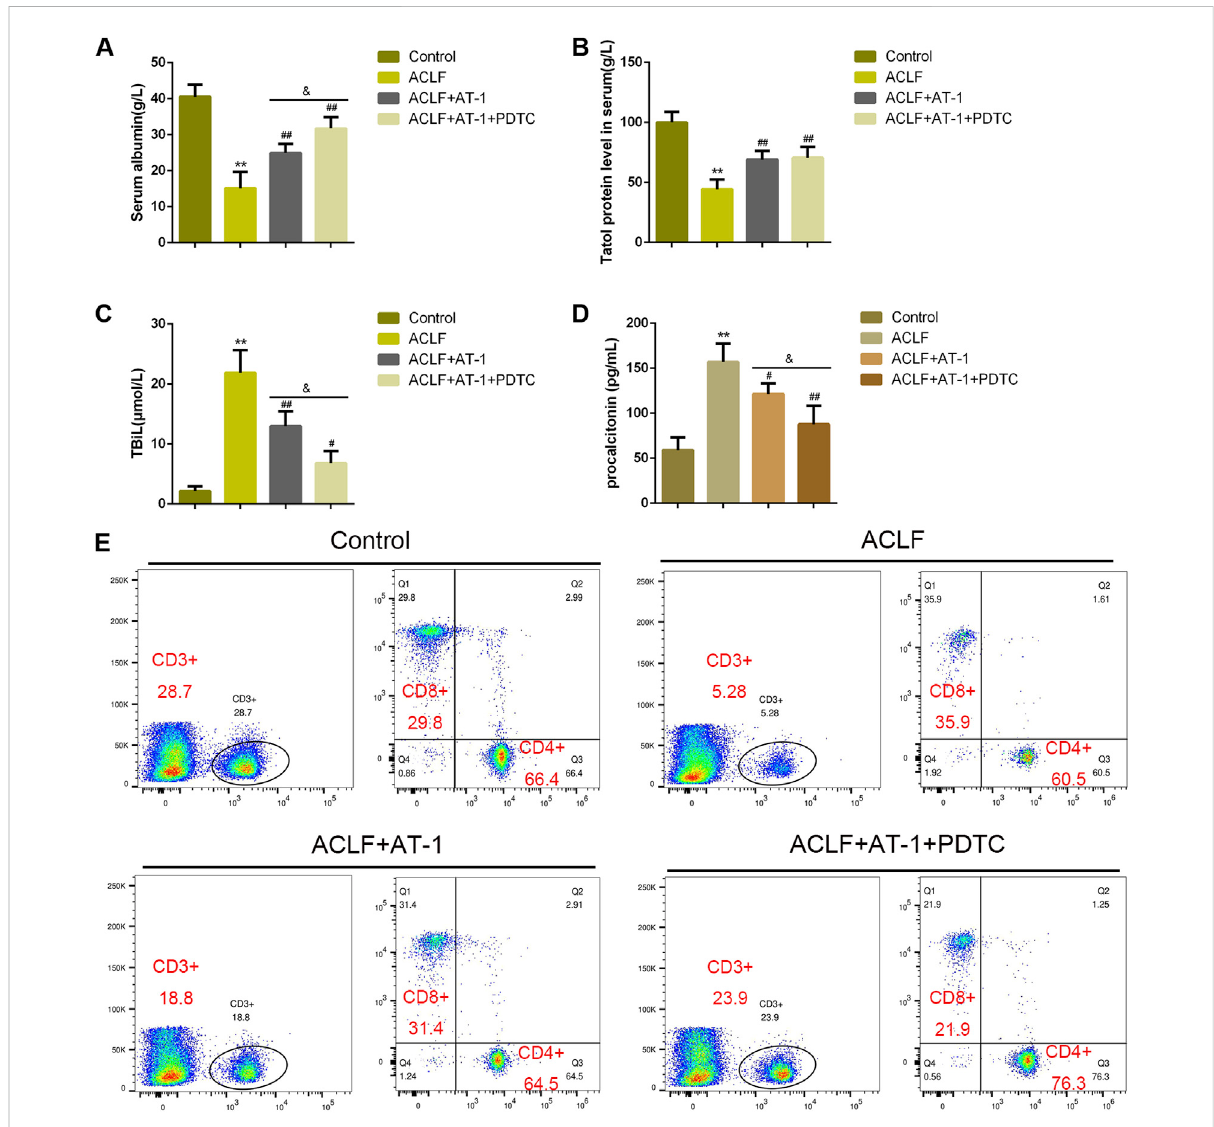
FIGURE 7 NF- κ B signaling is involved in AT-1 effects on in fl ammation in model rats. (A – D) Serum ALB, TPRO, TBIL, and PCT were examined using ELISA. (E) Lymphocytesubsets wereidenti fi edby fl owcytometry.N=6;** p < 0.01 compared tothecontrolgroup;# p < 0.05,## p < 0.01 compared tothe ACLF model group; && p < 0.01 compared to ACLF+AT-1